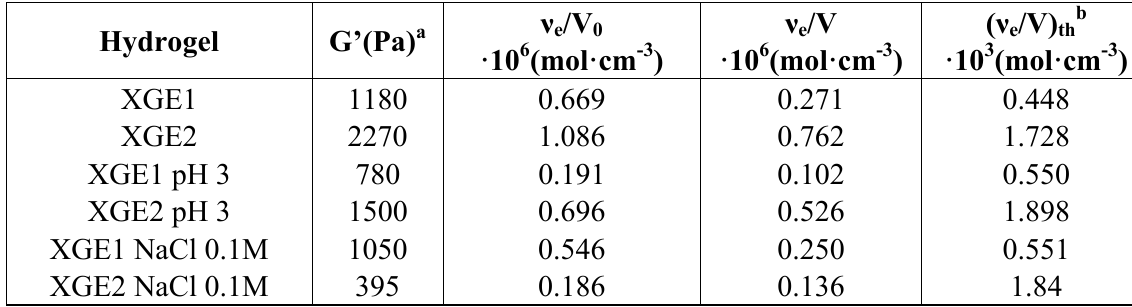
Table 3. Storage modulus and chain density in XGE